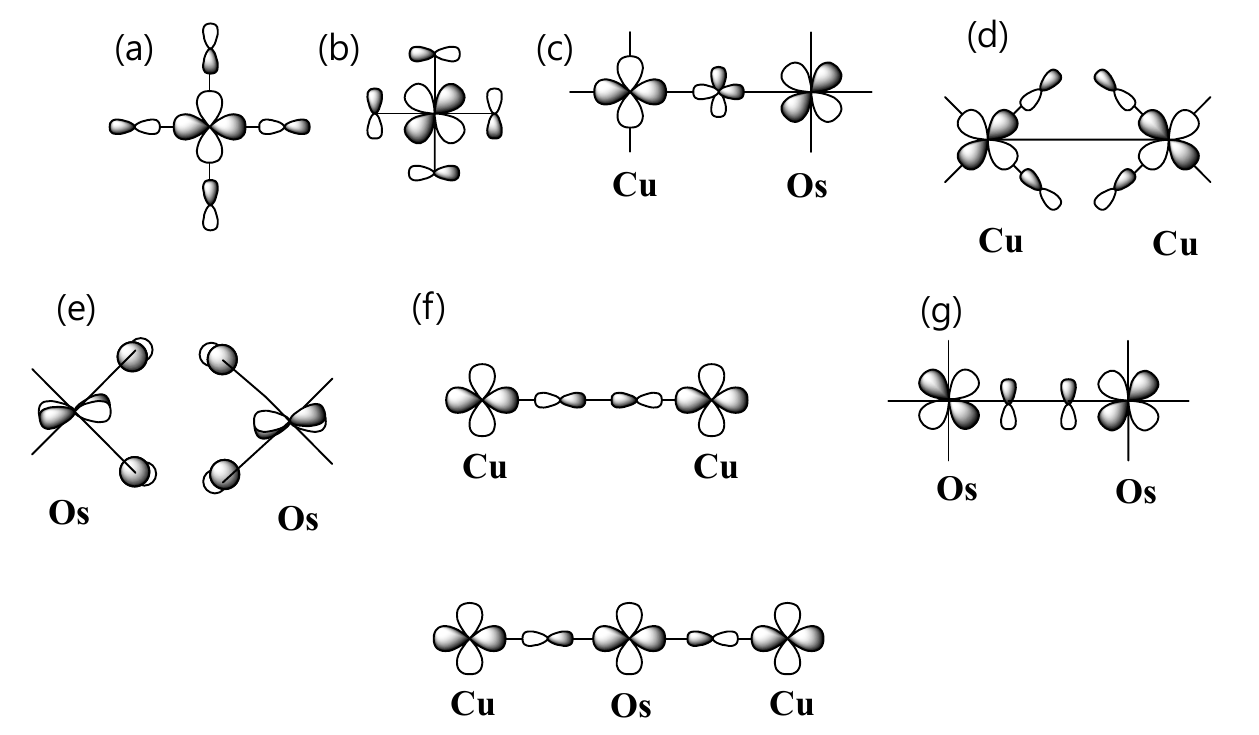
Figure 3. ( a ) The d x2–y2 magnetic orbitals of the Cu 2+ ion; ( b ) the t 2g -type magnetic orbitals of the Os 6+ ion; ( c – g ) the magnetic orbital interaction of J 1 , J 3 , J 4 , J 7 , and J 8 exchange paths in Ba 2 CuOsO 6 . We extracted the spin exchange interactions using the DFT + U + SOC